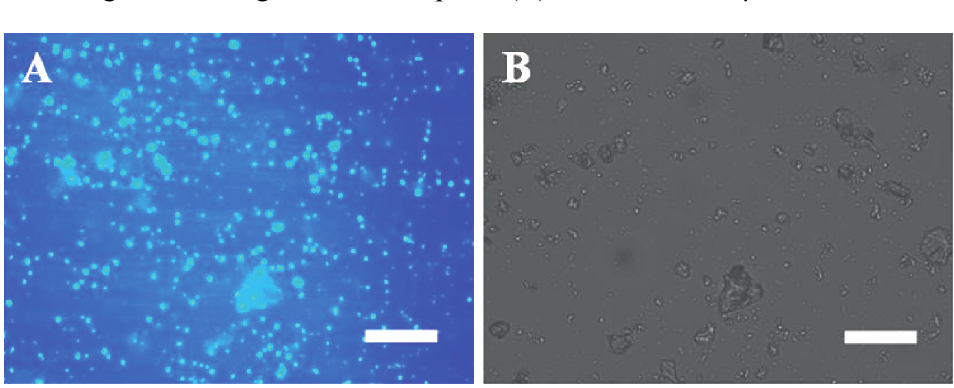
Figure 3. Photomicrographs showing travertine characterization by fluorescence microscopy which tavertine samples collecting at Jinshapudi sloping shoal in April. Panels ( A ) and ( B ) showing β -1, four-bond of polysaccharides labeled by Calcofluor white. Fluorescence image is shown in panel (A) and their blue colors indicate fluorescence signal. The bright field image is shown in panel (B). Scale bar: 100 μ